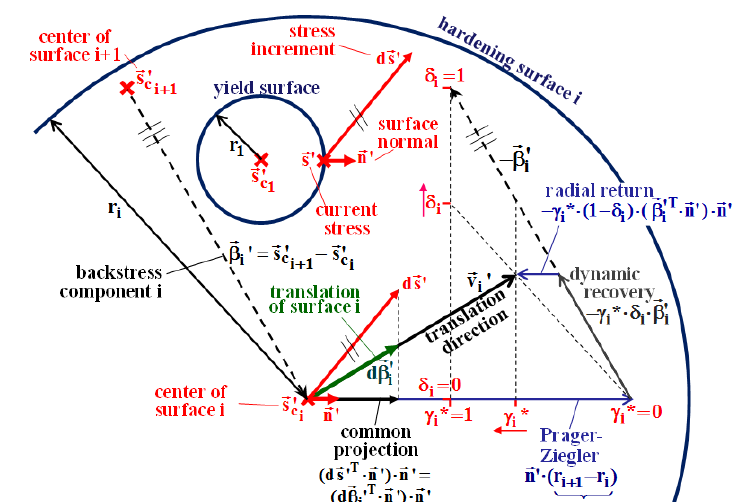
 of hardening surface i : Prager-Ziegler’s, v  i